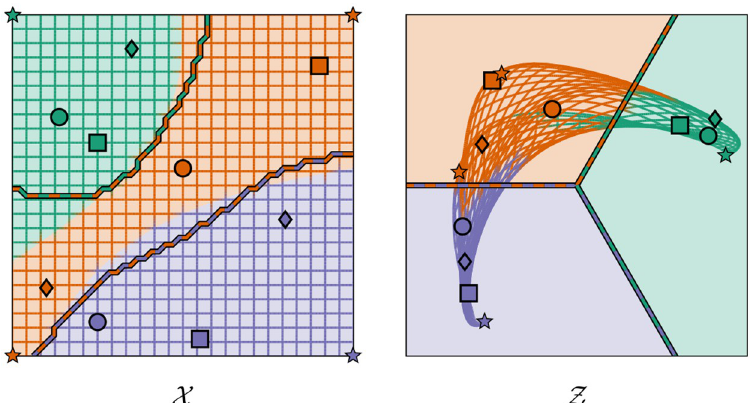
Fig 5. Illustration of our proposed calibrated simplex-mapping classifier. Illustration of our proposed calibrated simplex-mapping classifier ^ y : X ! Y for the exemplary ternary classification problem from Fig 3 based on the GPR model ^ f from Fig 4. According to our definition (27), the classifier determines for each feature space point x 2 X (on the left) the cone segment containing the latent space counterpart ^ f ð x Þ 2 Z (on the right) and then takes the label of this cone segment as the class label prediction ^ y ð x Þ 2 Y for x . In other words, the cuts of the cone segment borders through the latent space Z determine the class membership of each data point x according to its learned latent space position ^ f ð x Þ . We mark the predicted class boundaries (on the left) as well as the corresponding cone segment boundaries (on the right) by dashed lines. As can be seen, the predicted class boundaries in X do not deviate much from the true class boundaries indicated by the different background and grid colors on the left. In other words, our classifier produces only a few misclassifications. This can also be seen from the fact that the color of most of the transformed grid points in Z on the right (indicating the true class) is identical to the underlying background color (indicating the predicted class).